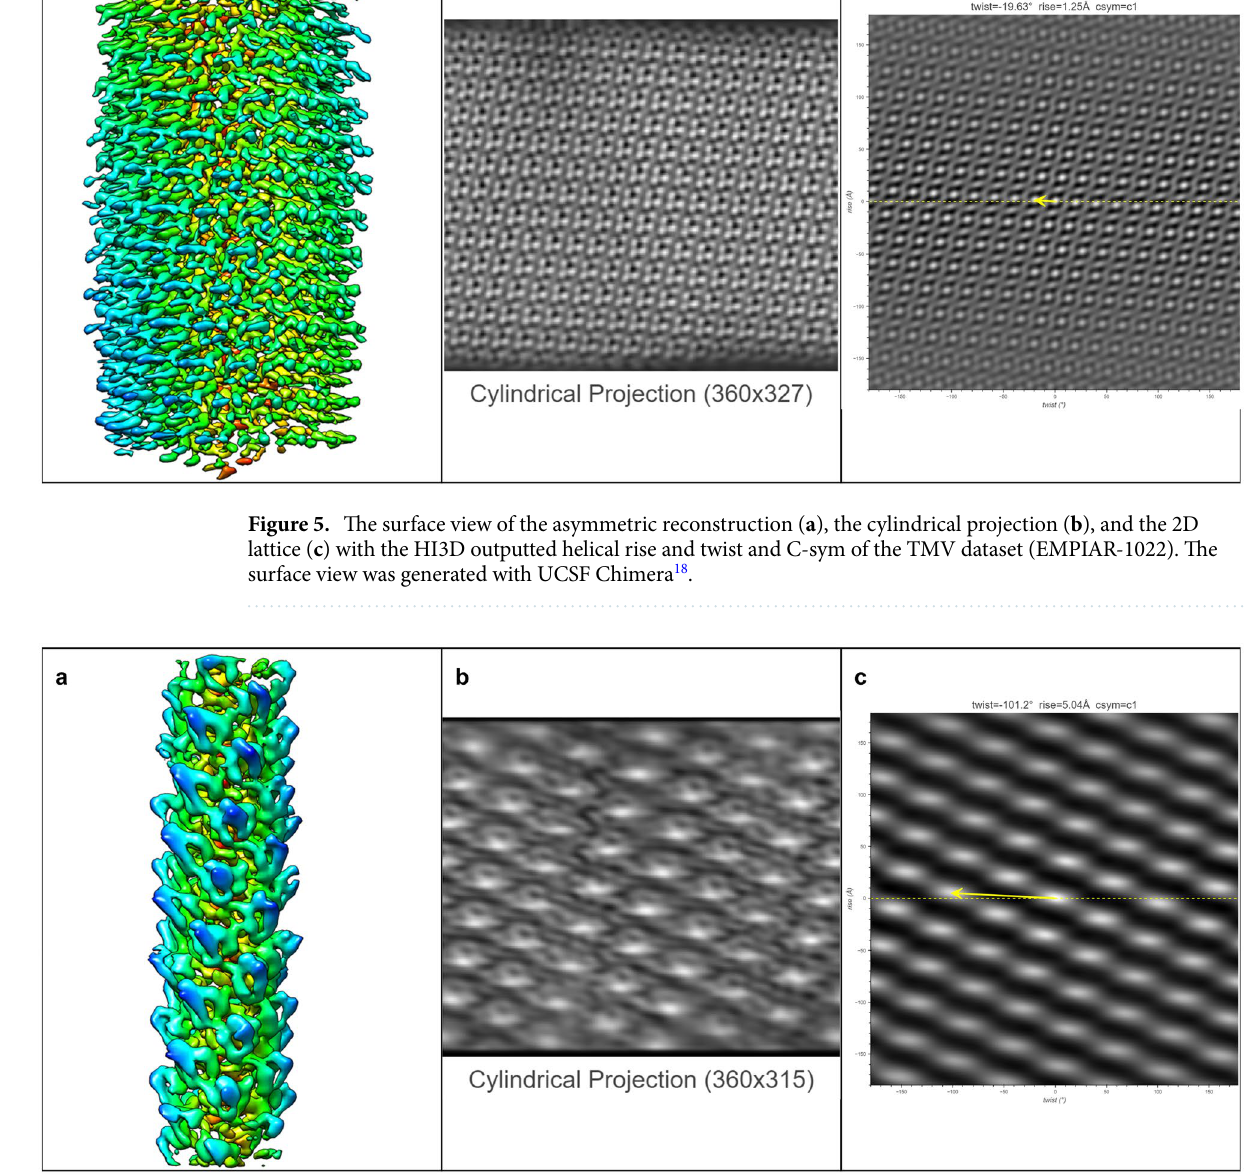
Figure 6. The surface view of the asymmetric reconstruction ( a ), the cylindrical projection ( b ), and the 2D lattice ( c ) with the HI3D outputted helical rise and twist and C-sym of the MAVS CARD dataset (EMPIAR-10031). The surface view was generated with UCSF Chimera 18